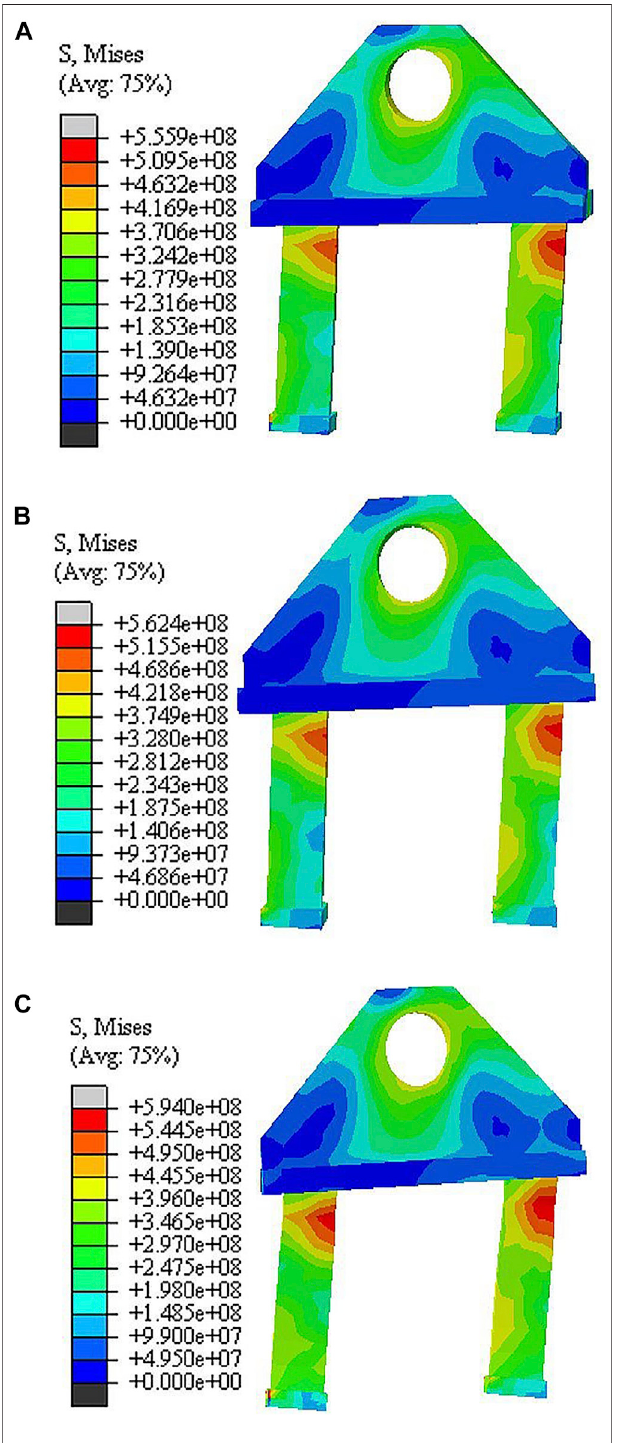
FIGURE 14 | Numerical stress distribution with different CSG (MPa): (A) C20-450 PESC, (B) C40-450 PESC, (C) C60-450 PESC.